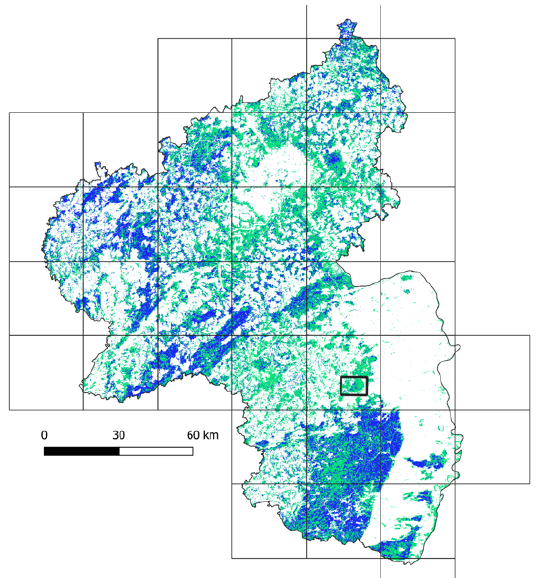
Figure 4. The S-2 analysis ready data collection (ARD) tile grid (ETRS89 Lambert Equal Area projection) for Rhineland-Palatinate, overlaid on total forest cover (2019) (https://lvermgeo.rlp.de, accessed on 22 November 2022); coniferous forest areas are shown in dark blue. The study area is marked by the black rectangle.